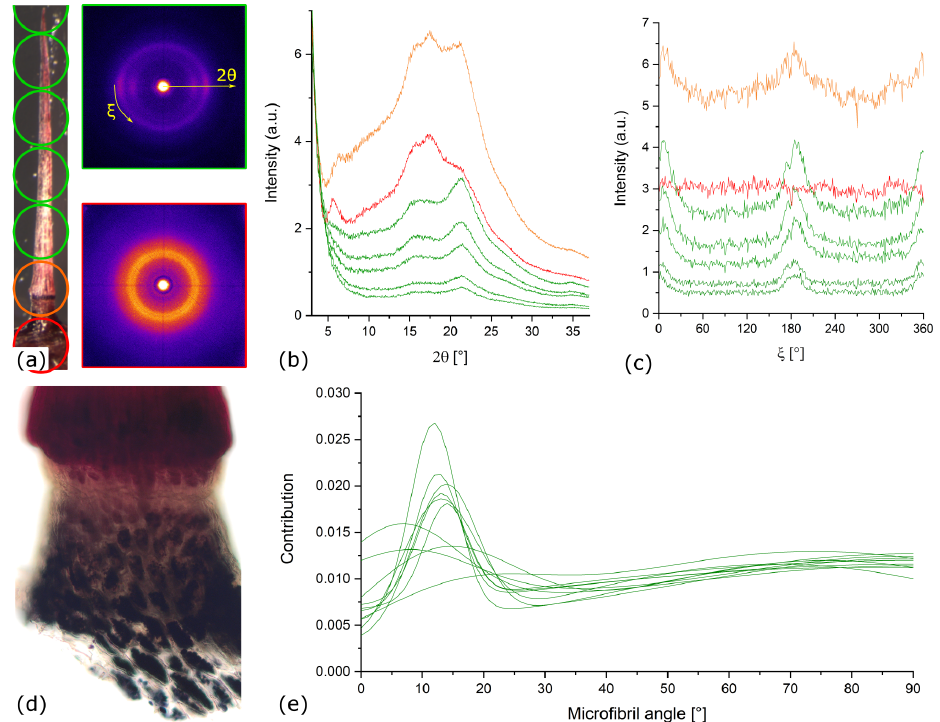
Figure A2. ( a ) X-ray scan along the sensory hair with a beam diameter (open circles) and a step size of 300 µ m and two representative diffraction images of the lever ( top ) and the podium ( bottom ). ( b ) 2 θ profiles of one scan. ( c ) azimuthal profiles of the (200)-Bragg reflection of cellulose from the same scan as in ( b ). ( d ) longitudinal section of the podium stained with iodine solution for visualising the starch grains. ( e ) Cellulose orientation distribution as relative contribution of microfibril angles in the range 0–90 ○ for all scanned levers. Colour code: green = lever, orange = transition lever-podium, red =